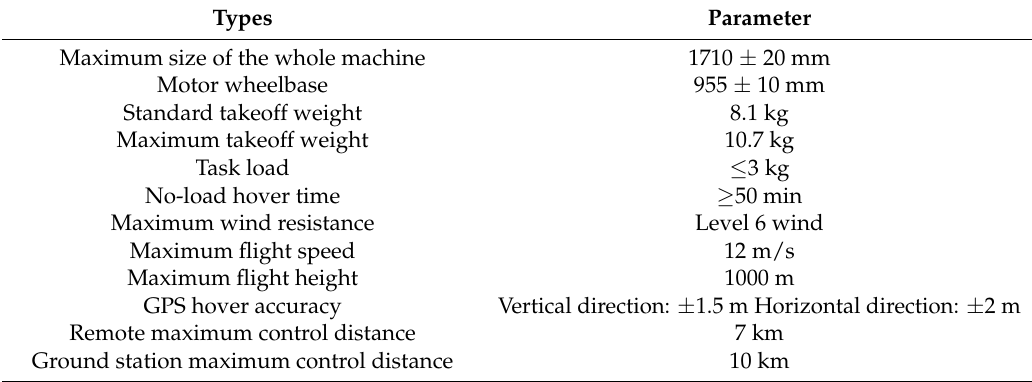
Table 1. The specific parameters of the employed drone. http://www.keweitai.com/products_detail/